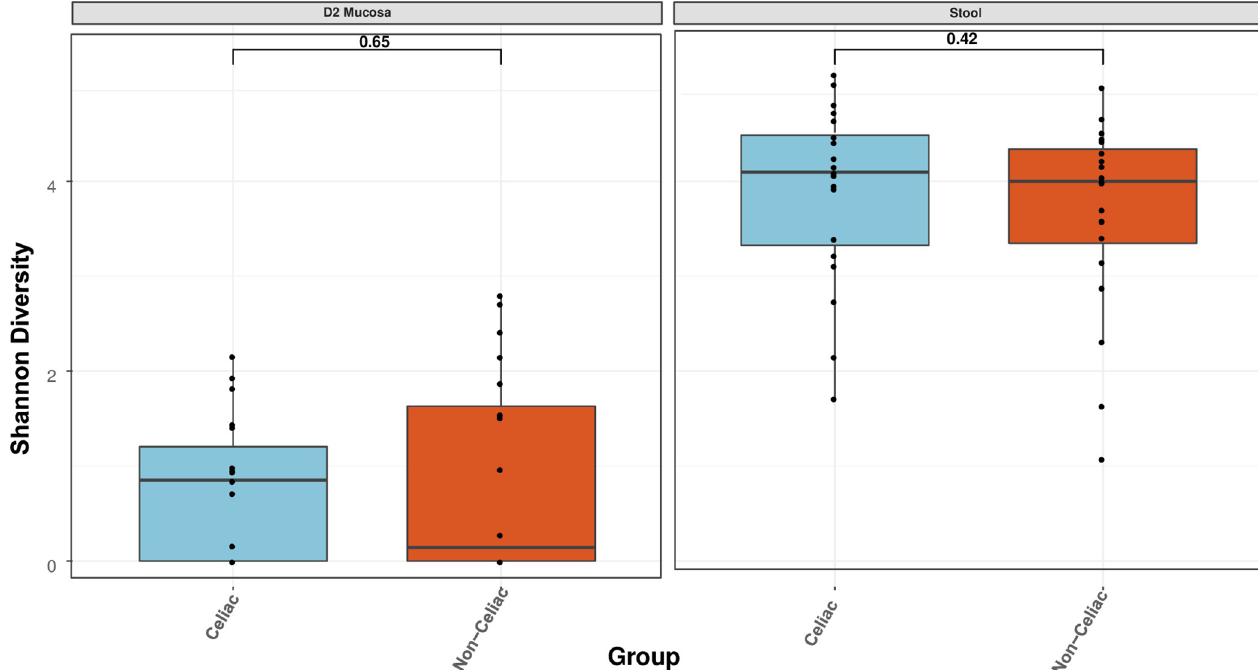
Fig 2. Shannon alpha diversity. Comparison of celiac and nonceliac samples, revealing no statistically significant difference in viral species diversity between mucosal (p = 0.65) or stool (p = 0.42) samples. However, there is a higher alpha diversity in fecal than mucosal samples.